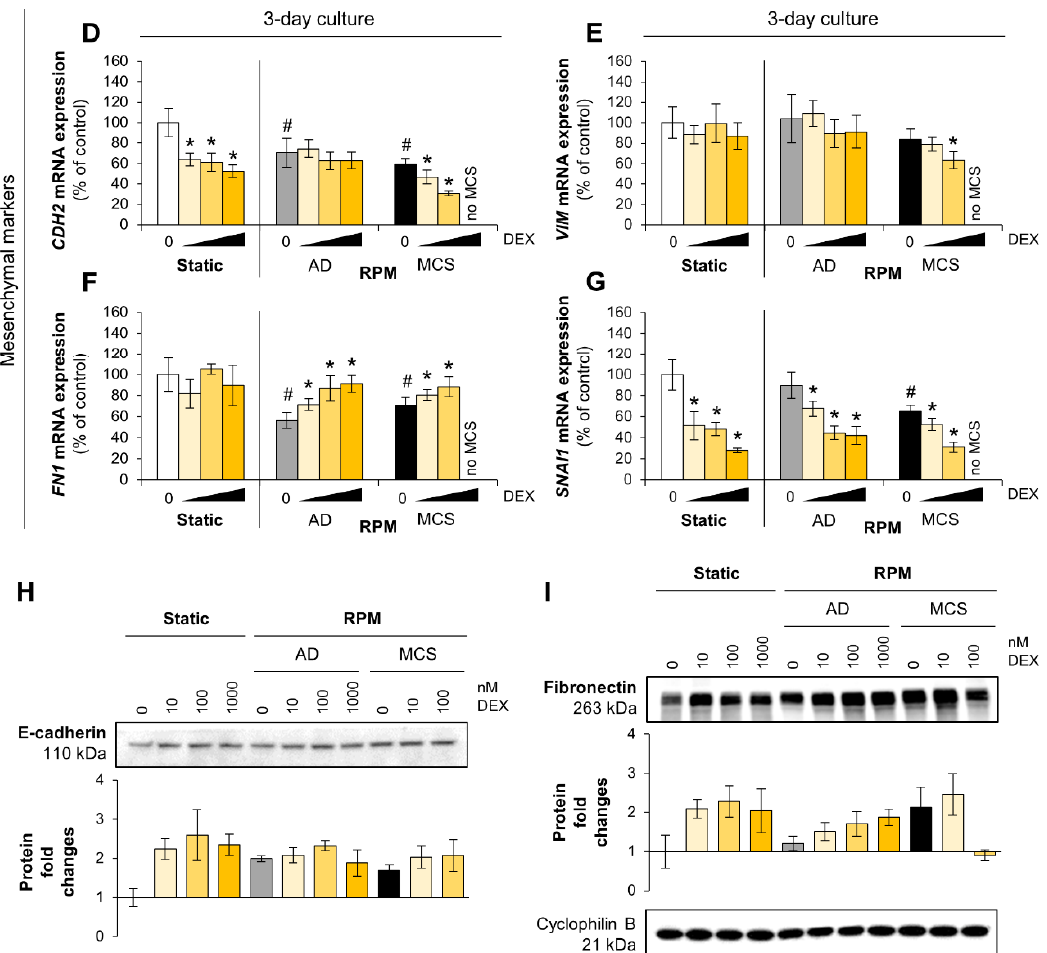
Figure 6. E ff ect of DEX on the mRNA synthesis of epithelial markers, mesenchymal markers, and other epithelial–mesenchymal transition (EMT) players in FTC-133 cells. ( A ) CDH1 mRNA expression; ( B,C ) Immunofluorescence. White arrows show translocation of β -catenin (green) into the nucleus (blue; DAPI-stained) both in µ g and in the presence of DEX. Yellow arrows indicate an increased occurrence of β -catenin on the plasma membrane in the absence of DEX. Scale bars: 20 µ m; ( D ) CDH2 mRNA expression; ( E ) VIM mRNA expression; ( F ) FN1 mRNA expression; ( G ) SNAI1 mRNA expression. Depicted are means of relative mRNA levels ± standard deviations ( n = 5). *: p < 0.05 vs. DEX-free samples. # : p < 0.05 vs. static cultures; ( H,I ) Western blots indicate protein levels of regulated genes after 3 days. Representatives of each of the three replicates is shown. Diagrams describe relative fold changes to control. AD: adherently growing cells; MCS: multicellular